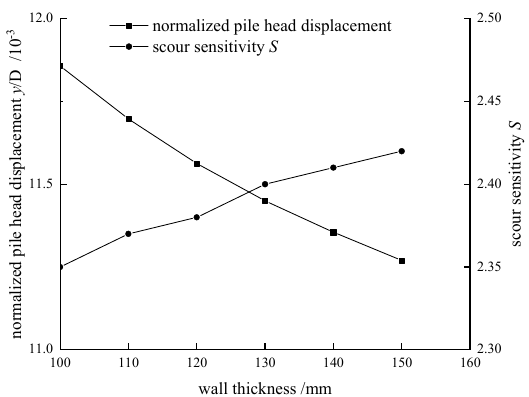
Figure 17. Pile displacement and scour sensitivity variation with embedment depth.